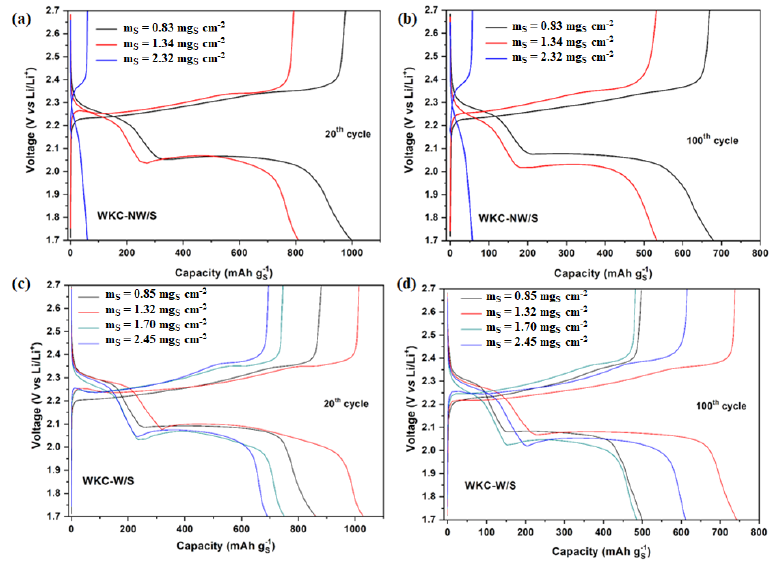
Figure 9. Discharge/charge profiles at 0.1 C for the 20th and 100th cycles at different mass loadings for WKC-NW/S ( a , b ) and WKC-W/S ( c , d ).